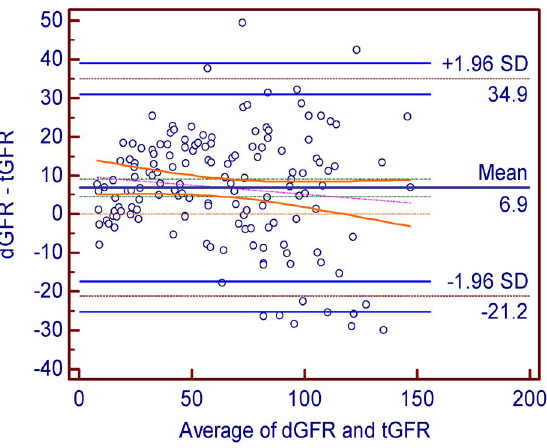
Figure 3. Bland-Altman plot showing the disagreement between dGFR or eGFR and tGFR. The solid long line indicates the mean of difference and the dotted long line represents the 95% limits of agreement. Abbreviations: dGFR- the GFR estimated by dynamic renal imaging method, eGFR- the GFR estimated by CDK-EPI equation method, tGFR- the GFR measured by dual plasma sampling method.